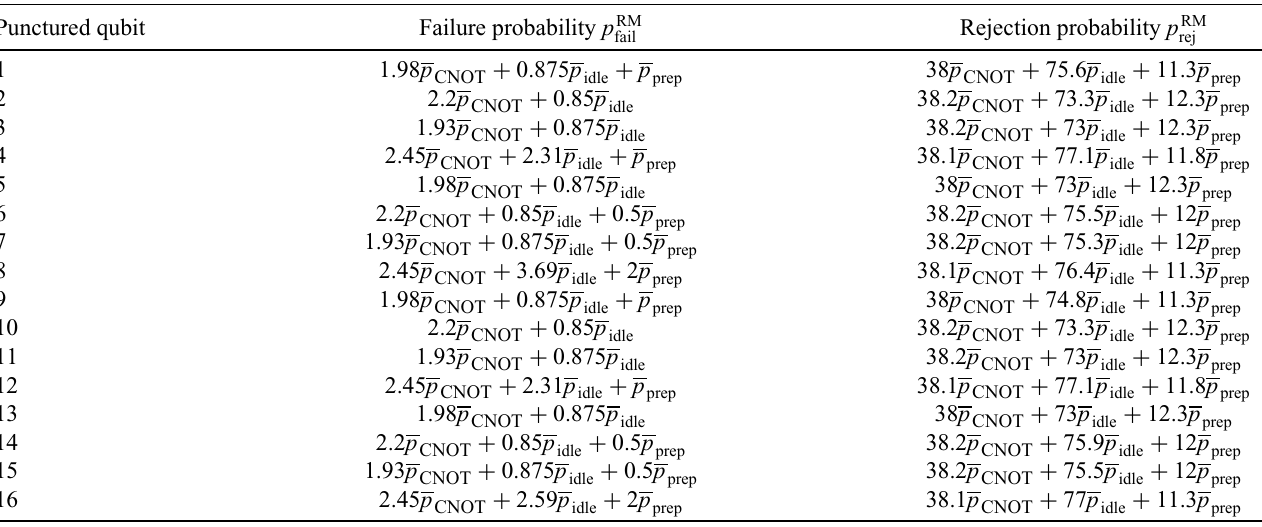
and rejection p RM of the 15-to-1 distillation scheme from fail rej